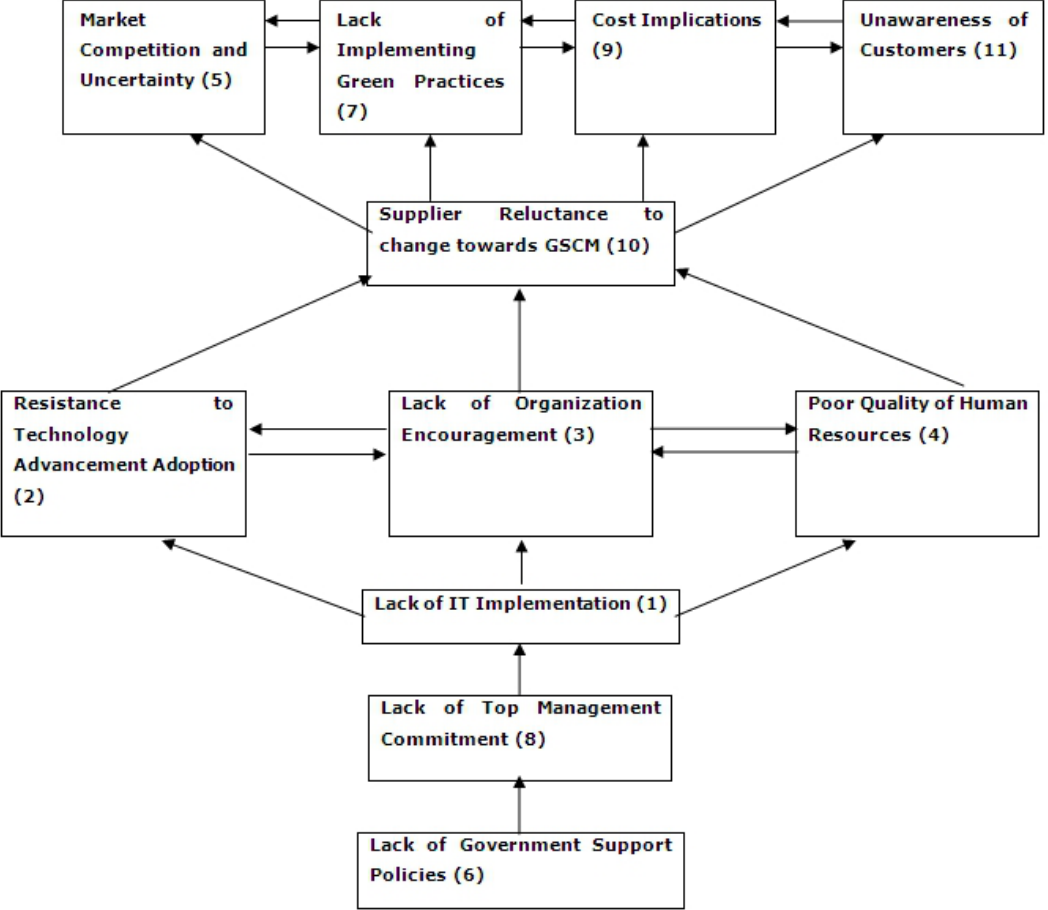
Figure 3. “ISM BASED Model for Barriers to Implement GSCM in Indian Automobile